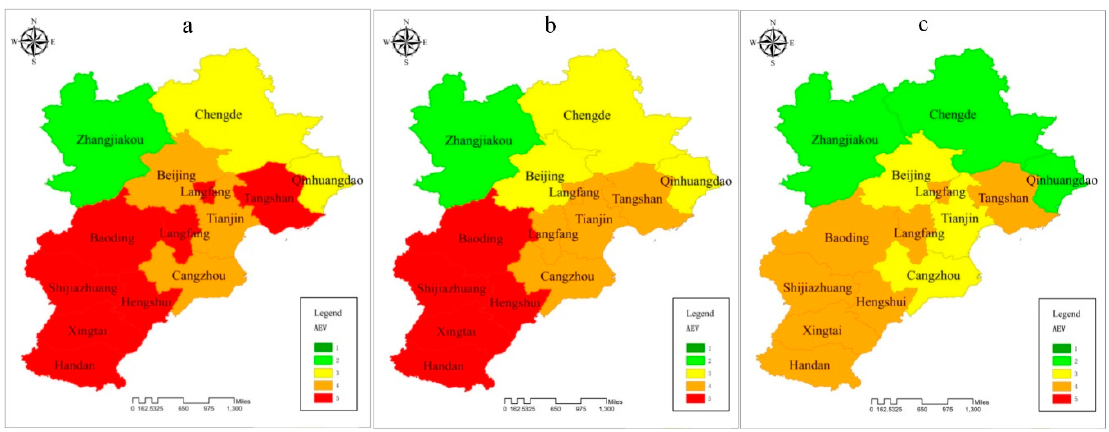
Figure 6. Aggregated atmospheric environment vulnerability assessment: ( a ) 2013; ( b ) 2014; ( c ) 2015.